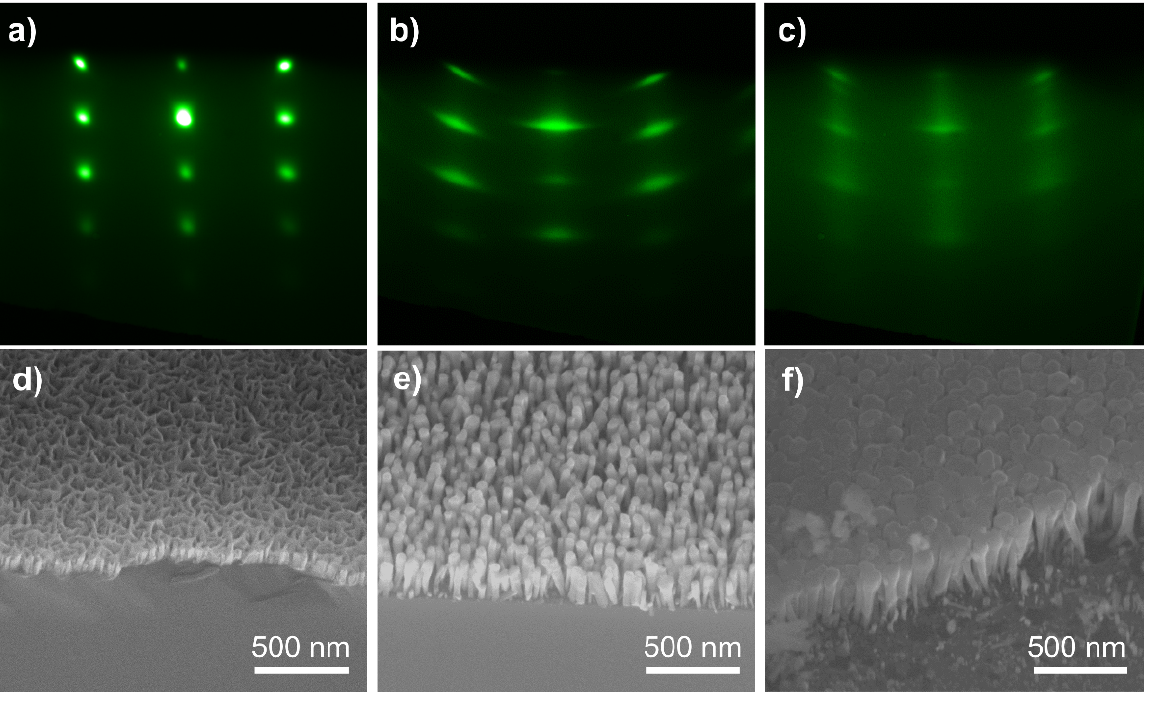
Figure 2. ( a – c ) the RHEED images of the AlGaN nanowires samples ( a – c ); ( d – f ) the SEM images of the AlGaN nanowires samples ( a – c ).